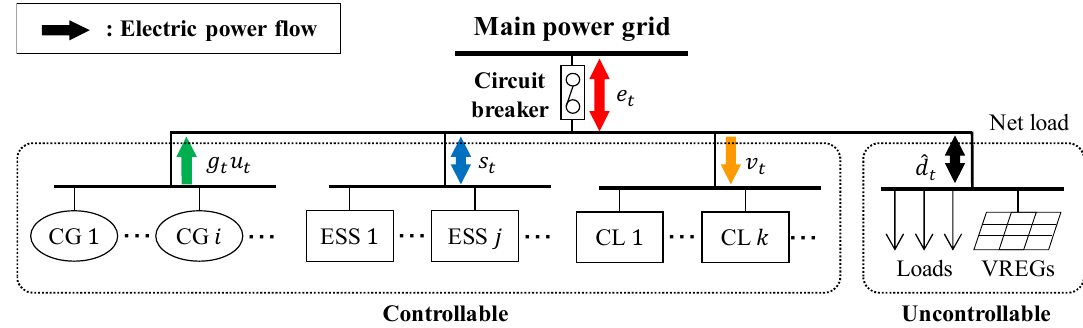
Figure 1. Example of a generalized microgrid model. CG, controllable generation system; ESS, energy storage system; CL, controllable load; VREGs, variable renewable energy-based generation